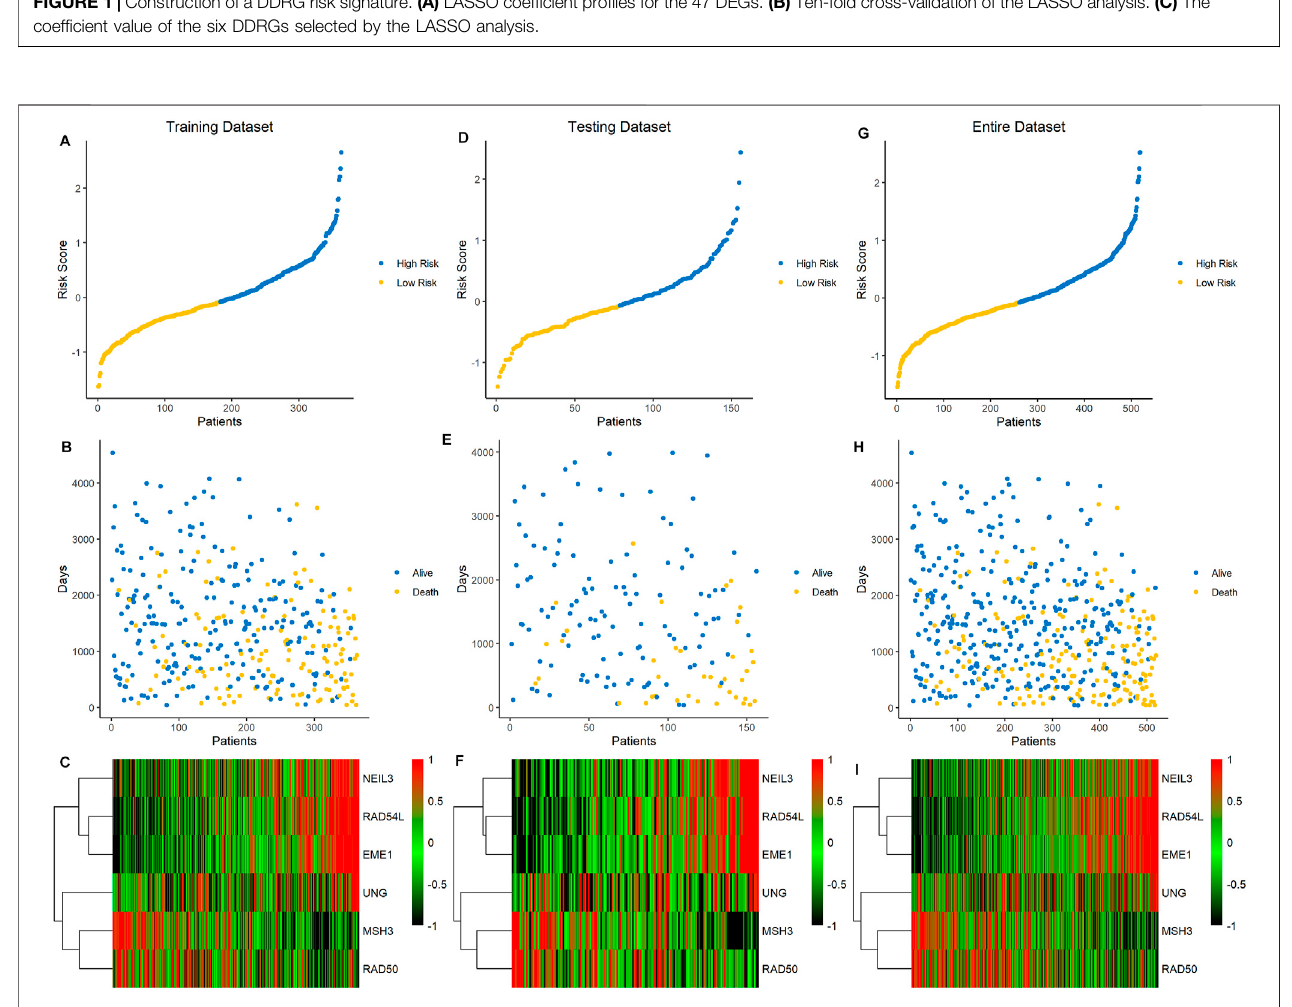
FIGURE 2 | Association between the risk score of six DDRG signatures and ccRCC patients in three cohorts. (A − C) Data of the training cohort, (D − F) data of the testing cohort, (G − I) data of the entire cohort. (A,D,G) The ranked dot plot of risk score distribution. (B,E,H) The scatter plot of patients ’ overall survival status. (C,F,I) The heatmap of expression pro fi le of the six signature